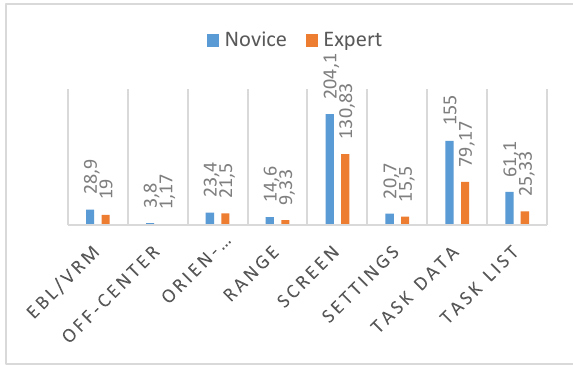
Figure 7. Comparison of means of AOI total fixation count of novice and expert participants on use of